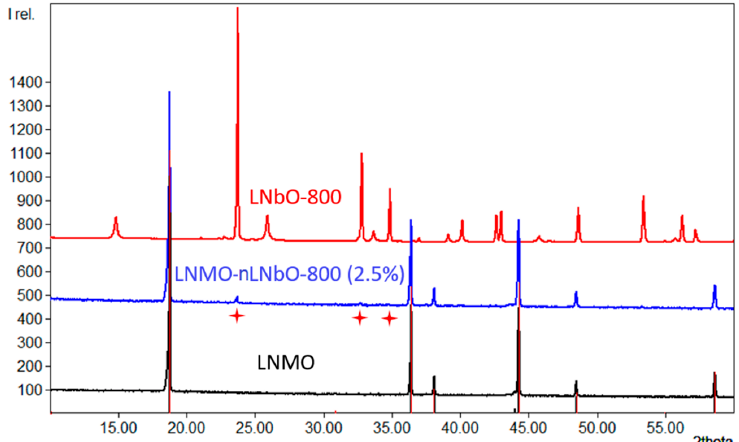
Figure 2. X-ray diffraction (XRD) patterns of uncoated LiMn 1.5 Ni 0.5 O 4 (LNMO), LNMO coated with 2.5 wt% LiNbO 3 and calcined at 800 °C (LNMO-nLNbO-800(2.5%)), and pure LiNbO 3 calcined at 800 °C (LNbO-800). The marked reflections (23.7, 32.7 and 34.8 2 θ ) are attributed to coated LiNbO 3 .